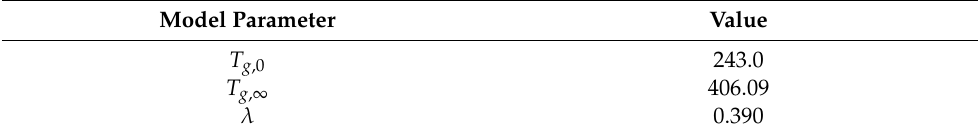
Table 3. Parameter values used for the DiBeneditto glass transition temperature